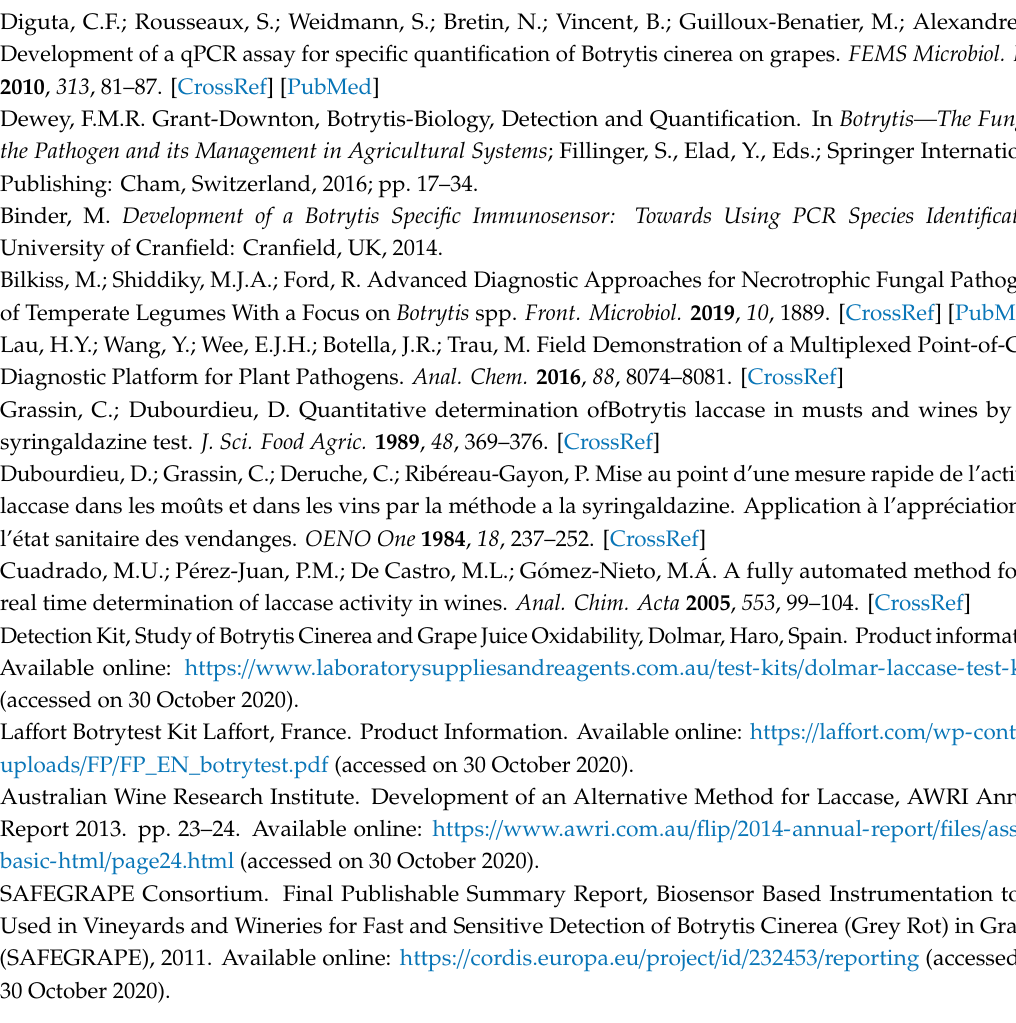
and average calibration curve for laccase activity determination obtained with CFMEs and chronoamperometry, Figure S2: Cyclic voltammograms recorded with a SPAuE in ABTS solutions with and without laccase, Figure S3: Calibration curve for laccase activity determination using the spectrophotometric method with ABTS and comparison between the proposed electrochemical assay with ABTS and the spectrophotometric method with